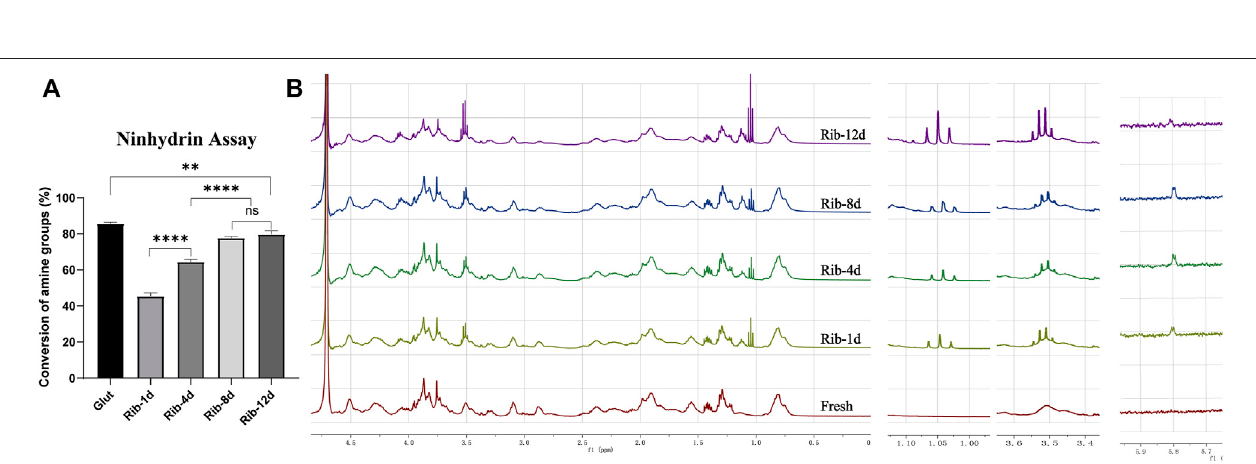
FIGURE 2 | Decellularization process of the BP. (A) H&E staining of the native BP. (B) H&E staining of the decellularized BP. (C) Quantitative determination of the DNA content ( n = 4) in the native BP and decellularized BP (scale bars: 200 µm; * p < 0.05, ** p < 0.01, and *** p < 0.001; ns represents no signi fi cant difference).